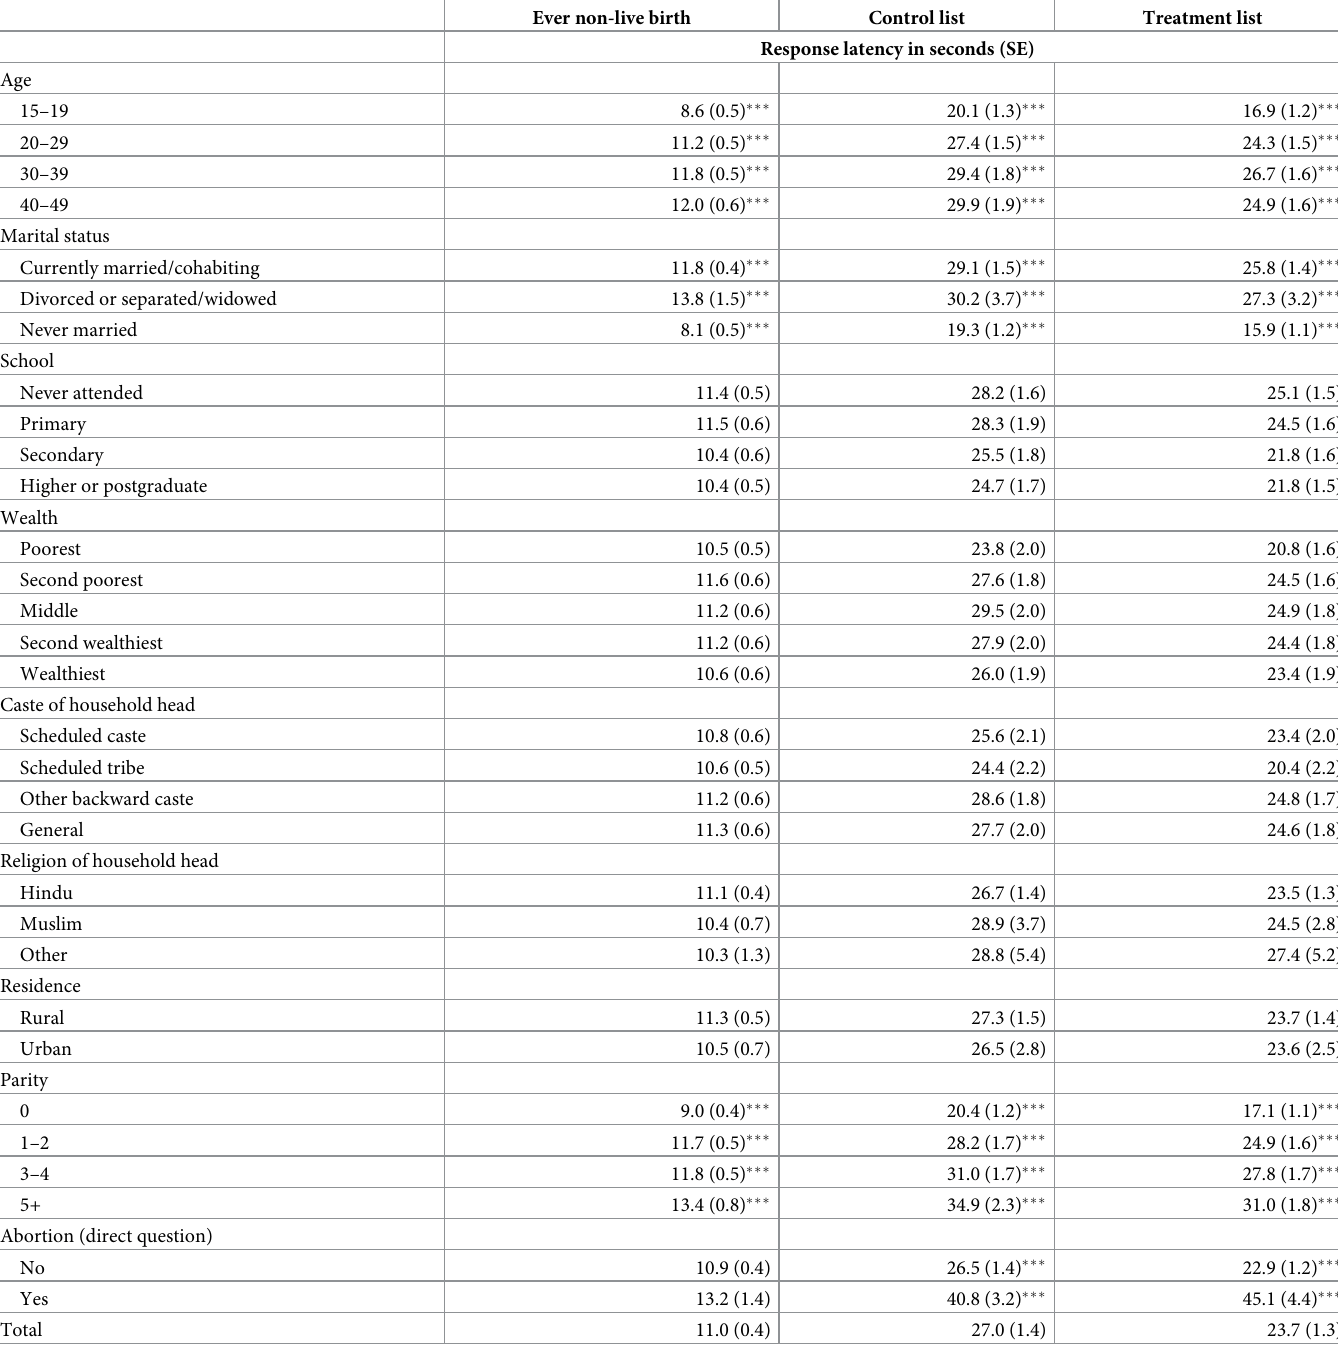
Table 3. Average response latencies in seconds to list experiment questions in seconds among Rajasthani women age 15 to 49, by socioeconomic characteristics and question (N = 6,017) 1